Question: What visual encoding does this figure use to show its data?
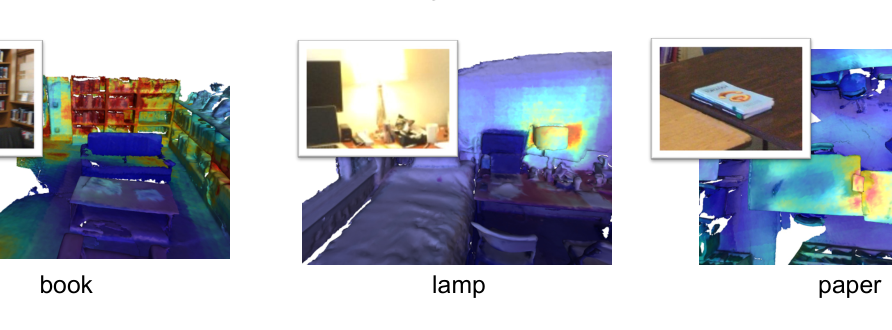
Answer: heatmap